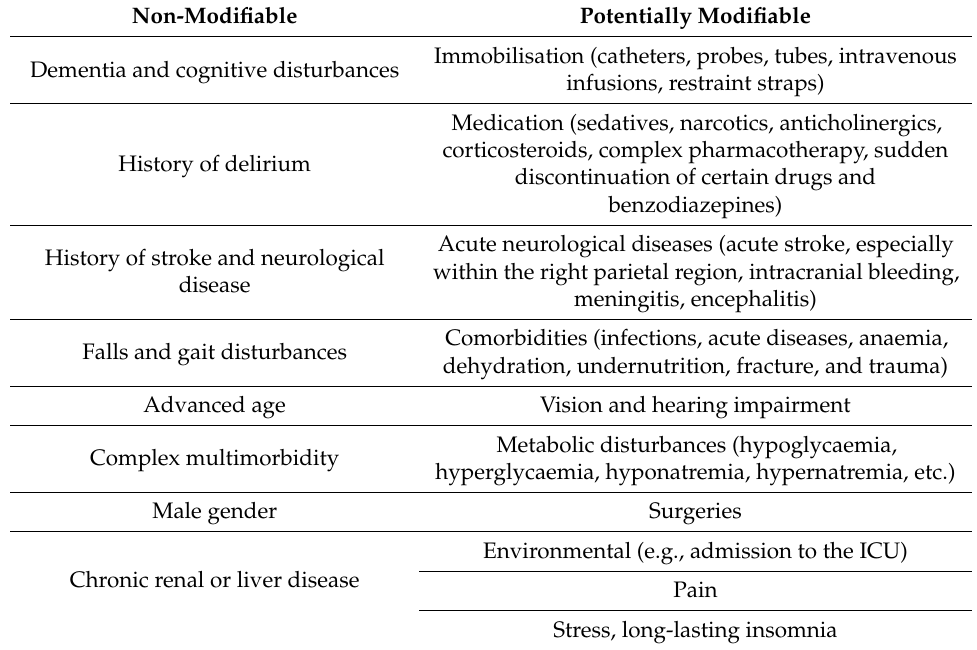
Table 1. Risk factors for the development of delirium in an Intensive Care Unit (ICU)